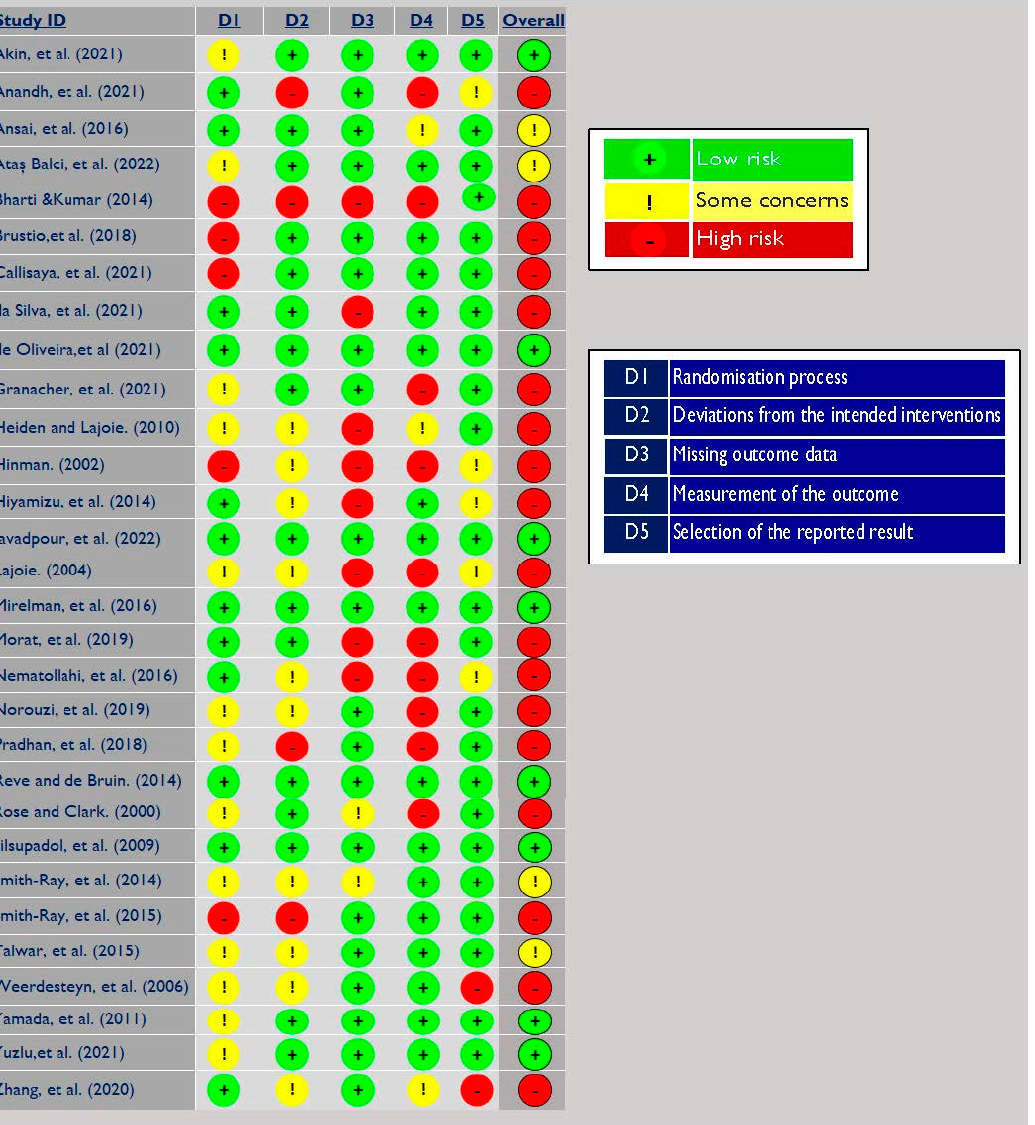
Figure 2. Risk of bias analysis of the included studies [21–23,28–30,44–67].